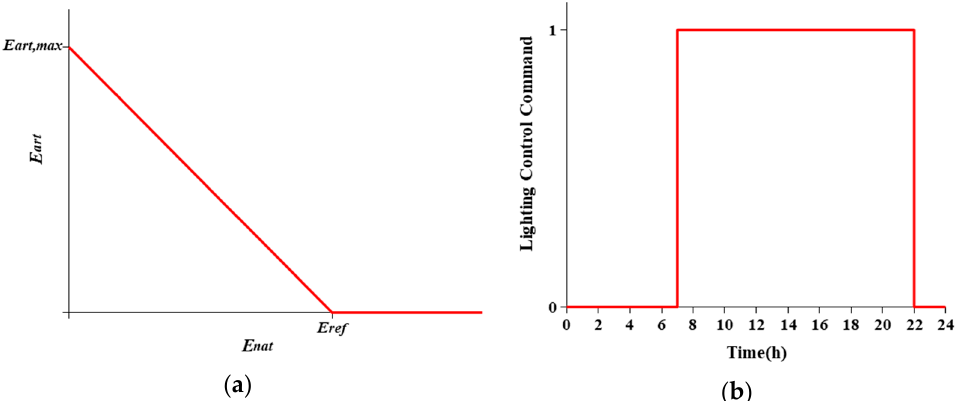
Figure 3. Control command of the HVAC system based on acceptable PMV range: ( a ) cooling process and ( b ) heating process.